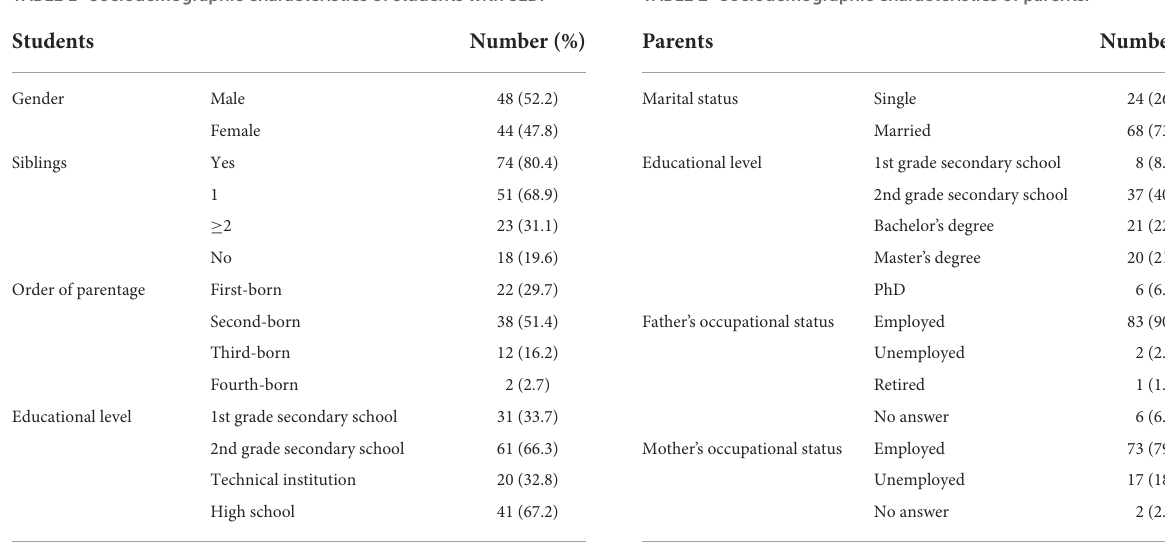
TABLE 1 Sociodemographic characteristics of students with SLD. TABLE 2 Sociodemographic characteristics of